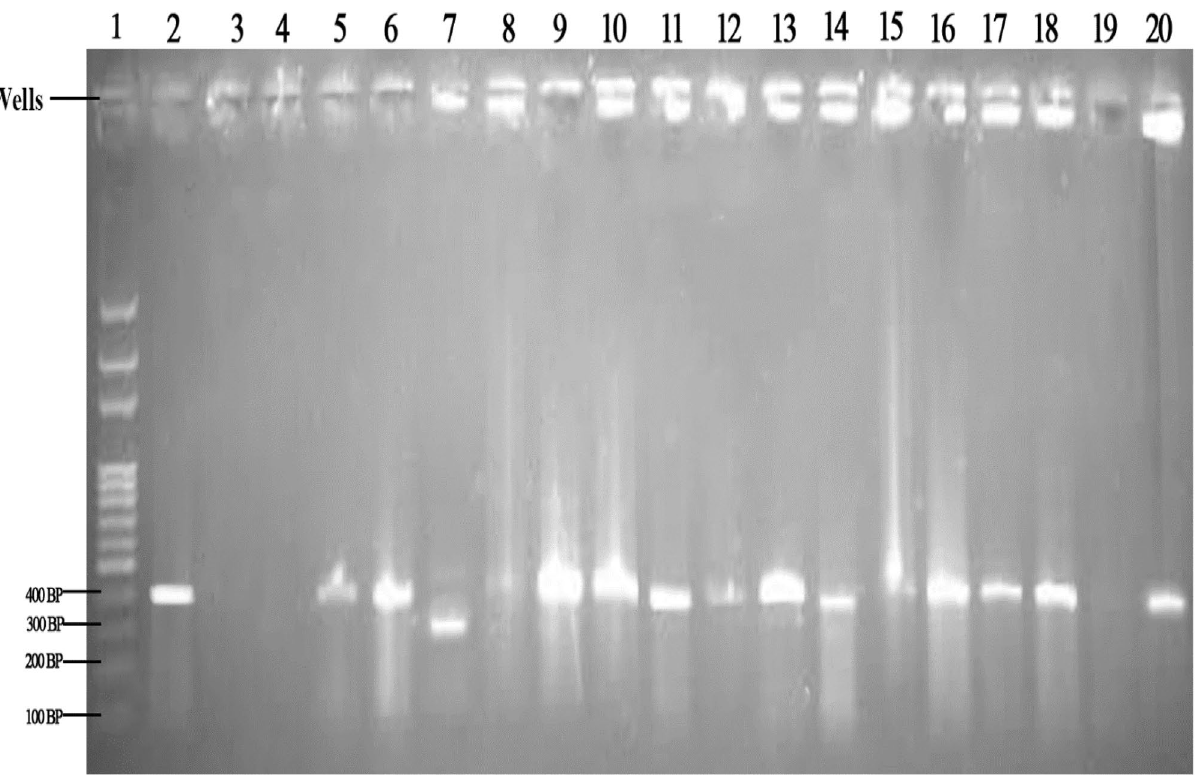
Figure 1. Agarose gel of the DNA fragment of amplified PCR of Anopheles gambiae complex. Well 1 represent 100 base pair (BP) DNA ladder. Well 2 a positive control, well 3 a negative control, well 5, 8, 9, 10, 11, 12, 13, 14, 15, 16, 17, 18 and 20 represent Anopheles gambiae s. s. 390 base pair. well 7 represent Anopheles arabiensis 315 base